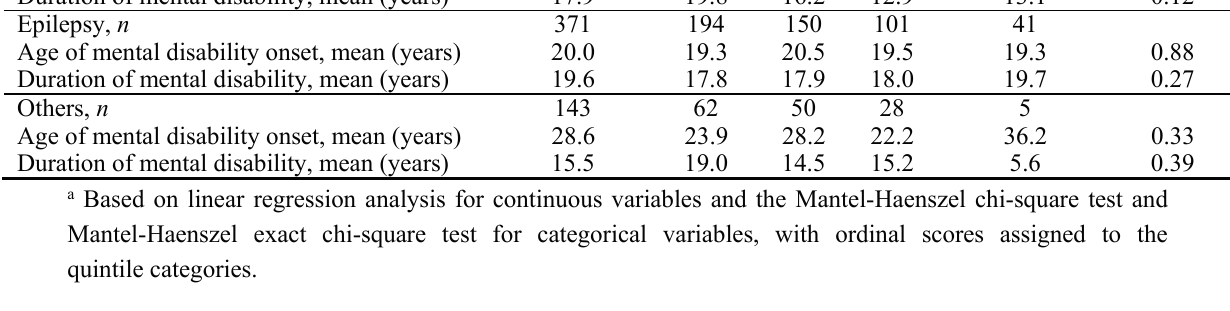
Table 5. Characteristics of different severities of mental disability by wealth index quintiles a . Variable